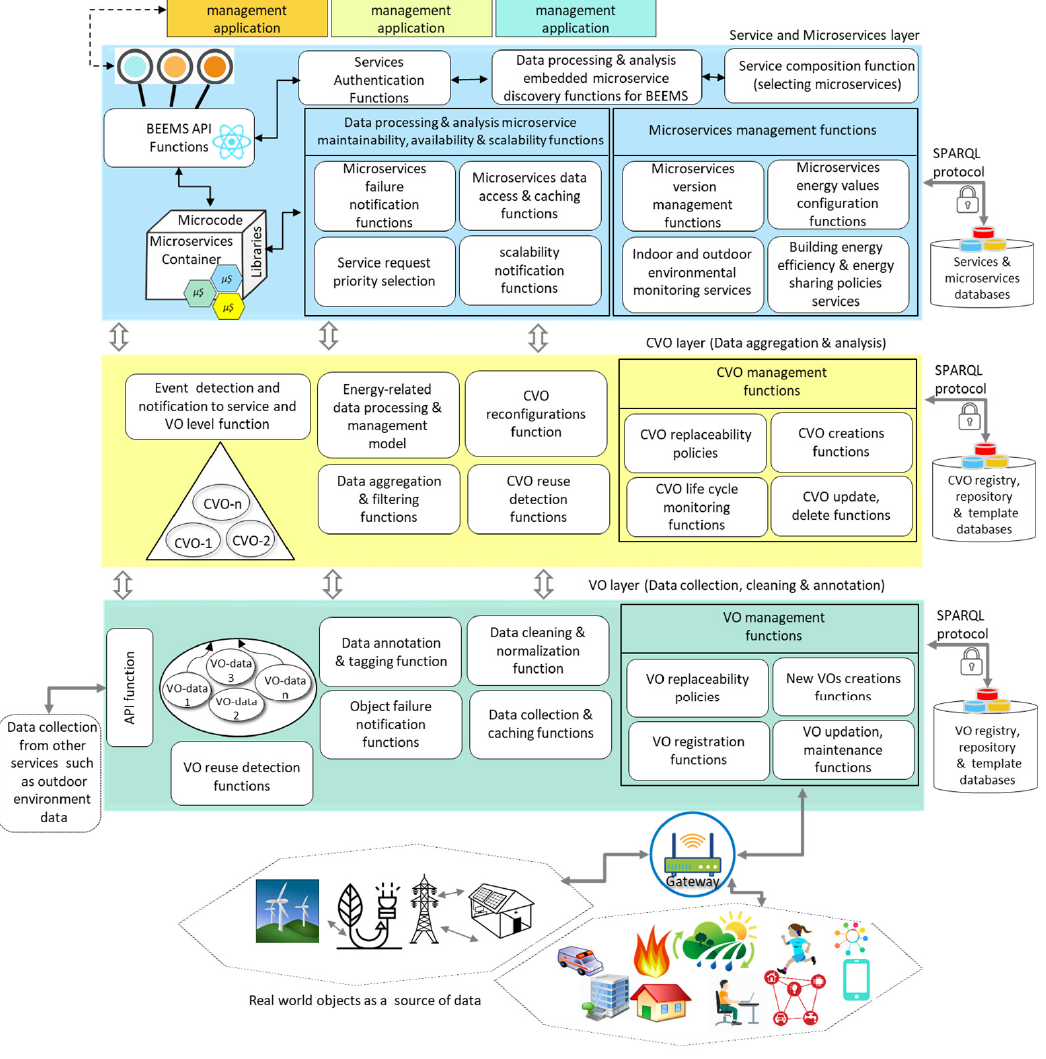
Figure 1. Microservices-based functions in Web Objects architecture to enhance data for buildings energy efficiency management services.